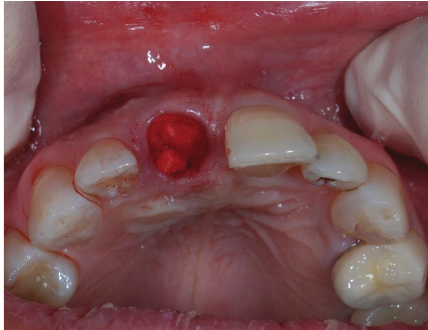
Figure 4: Occlusal view of the fresh alveolar socket after extraction and application of Spongostan (cid:2)